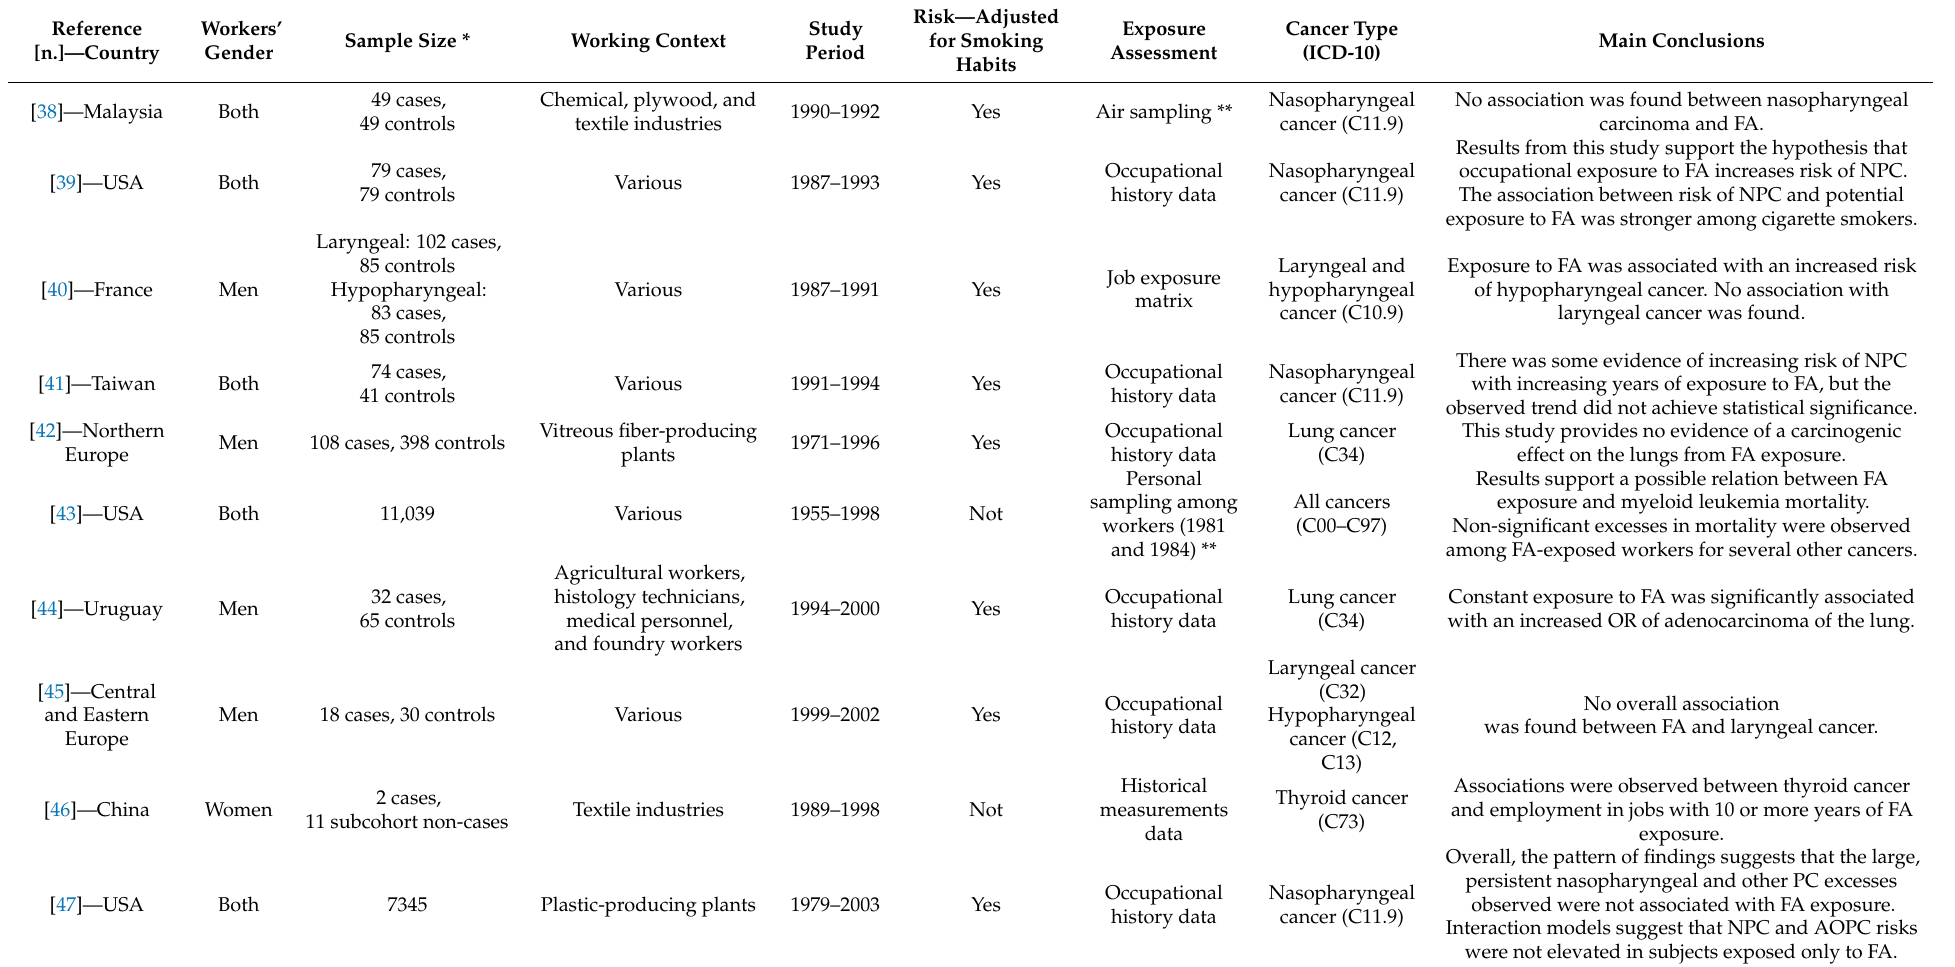
Table 1. Characteristics of the studies ( n = 21) included in the systematic